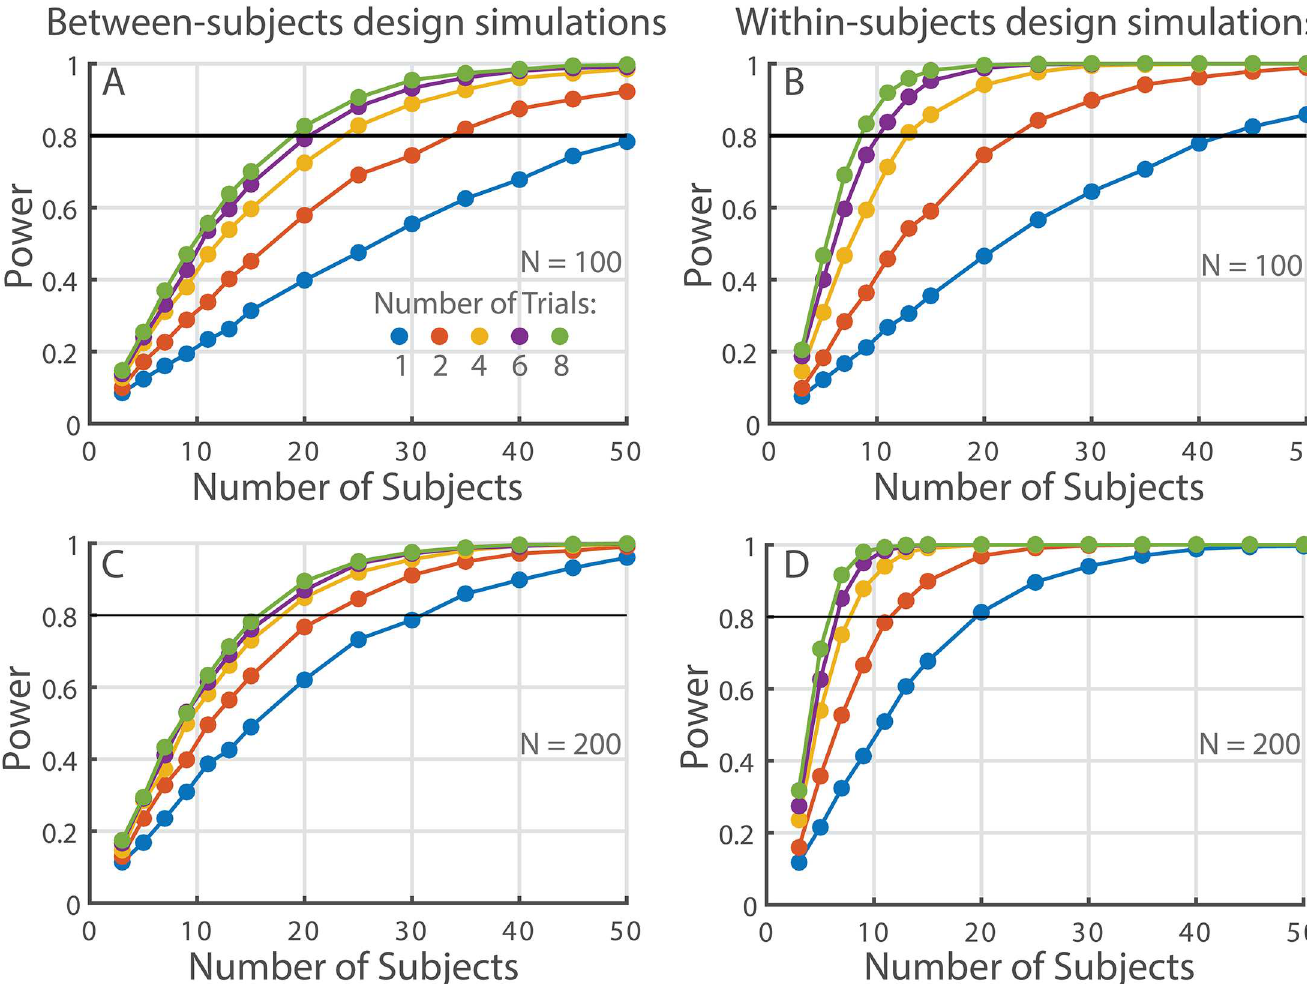
Fig 2. Simulation results. (A-B) These panelsdepict the expected power for between-and within-subject designsusing 100 strides and an expected group difference of 0.1, corresponding to a medium effect size. (C-D) depict the same information for 200 strides per trial.